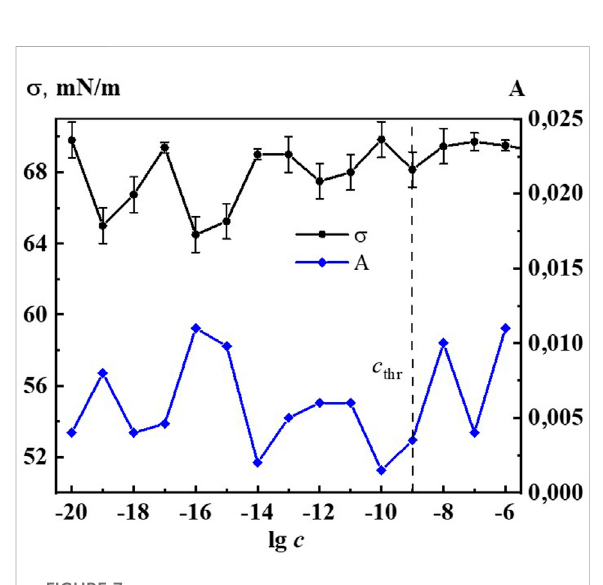
logarithm concentrations (c/M) of